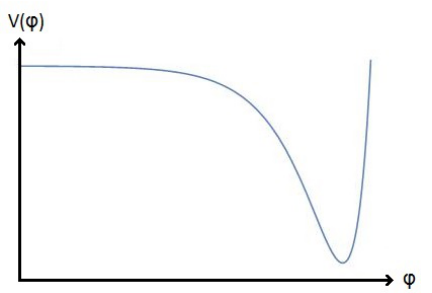
Figure 1 . Typical potential of a single (cid:12)eld in(cid:13)ation model in agreement with observational constraints. The end-point is a stable de Sitter solution, while the in(cid:13)ation phase is almost an (unstable) de Sitter